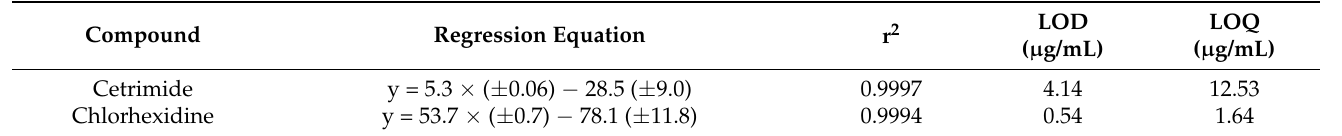
Table 3. Regression analysis results, LOD and LOQ values.